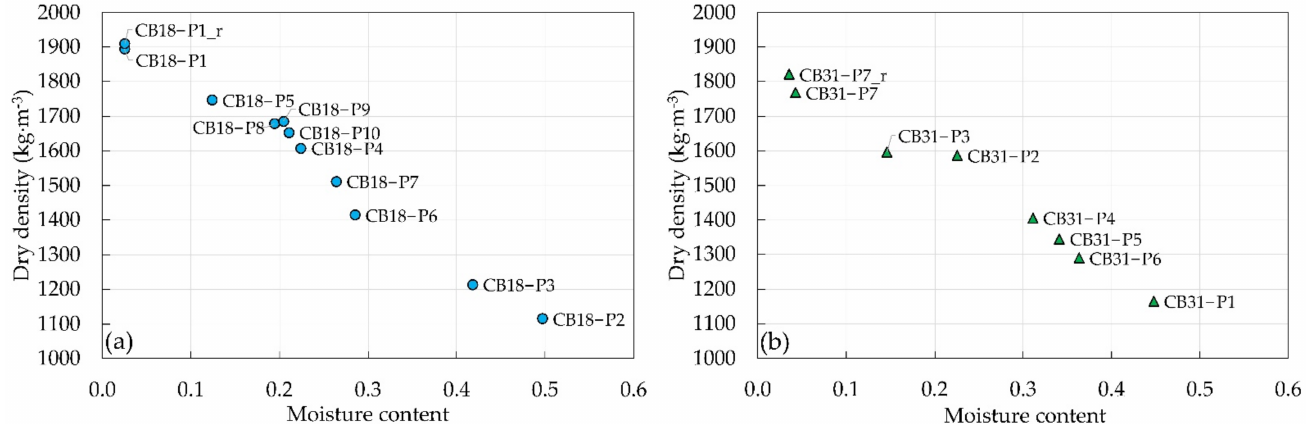
Figure 7. Summary of the Standard Proctor Tests: ( a ) Soil mixtures with a bentonite content of 18%; ( b ) Soil mixtures with a bentonite content of 31%. The subscript ‘r’ stands for ‘repeated’. Figure 8a,b present, respectively, the indicative strength measurements obtained with the Geotester Pocket Penetrometer and the Humboldt H-4212MH Pocket Shear Vane Tester, performing four and three measurements on average on each face of the Proctor samples with each device. The red dots represent an estimate for a CB18 mixture with an optimal moisture content of 20% and a relative maximum dry density ρ d,max = 1692 kN · m − 3 . The Proctor optimal moisture content is discussed in Section 4.1.